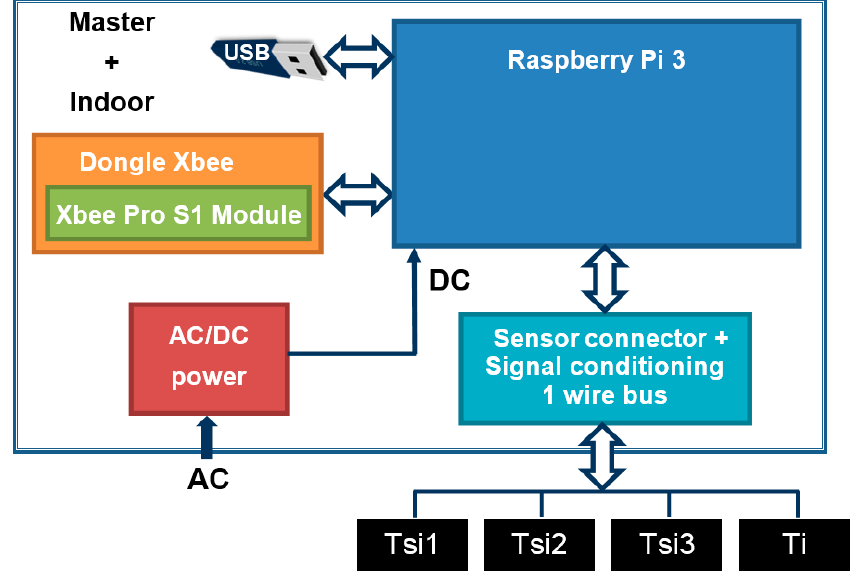
Figure 3. Master + indoor module block diagram.